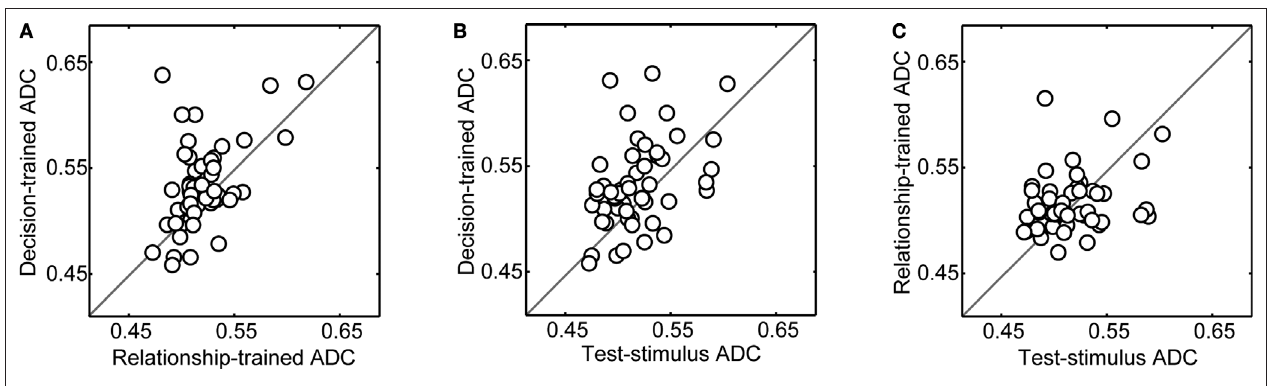
FIGURE 5 | Population analysis of average decoding capacity (ADC). In each panel, on a neuron-by-neuron basis, two of the three ADC values are compared. In panel (A) , the decision-trained-ADC values and relationship- trained-ADC values are compared. In panel (B) , the decision-trained-ADC